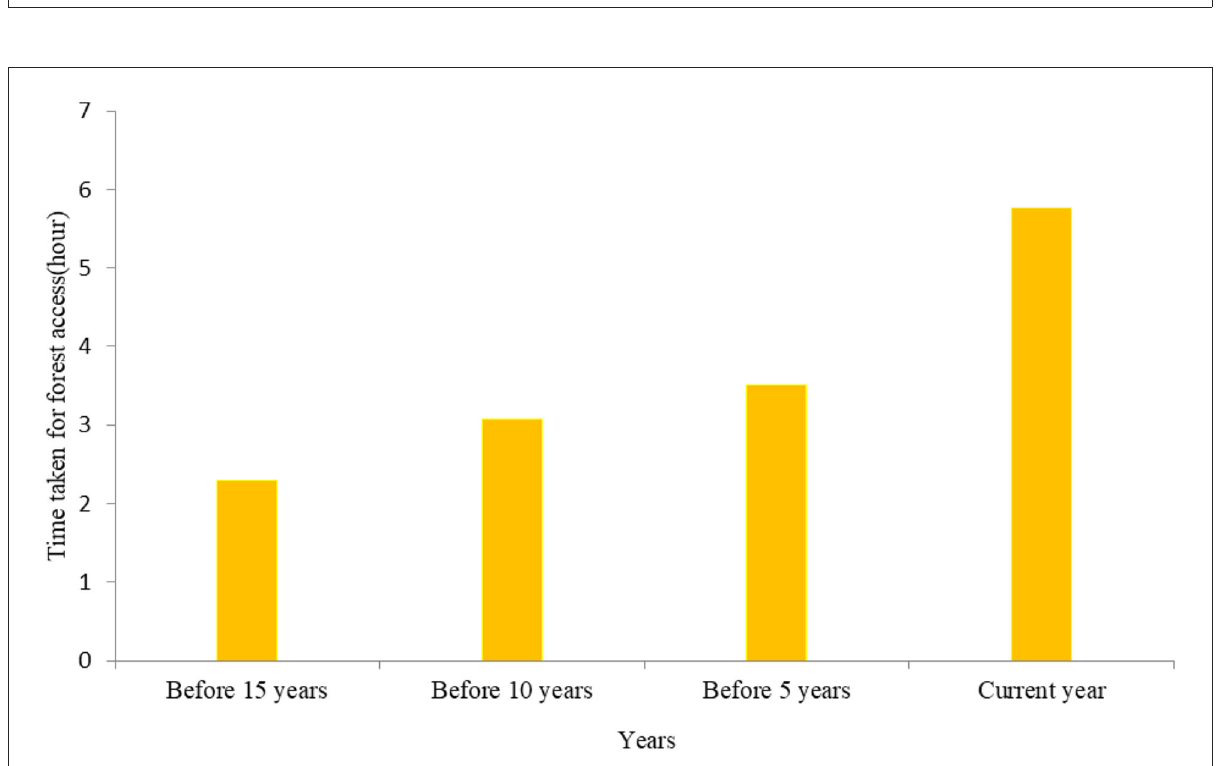
FIGURE6 Trend of forest access to wood fuel